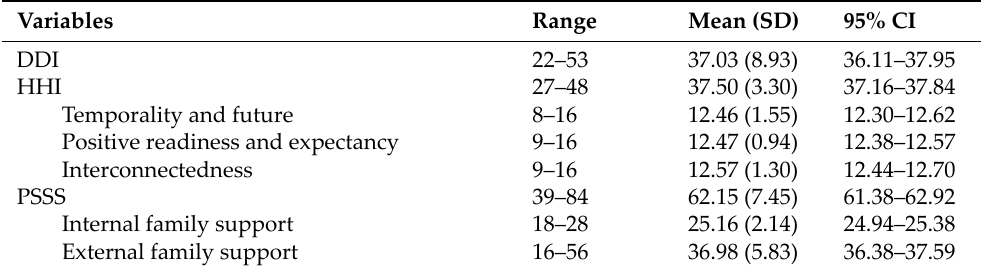
Table 3. The scores of other psychosocial variables ( n = 363).